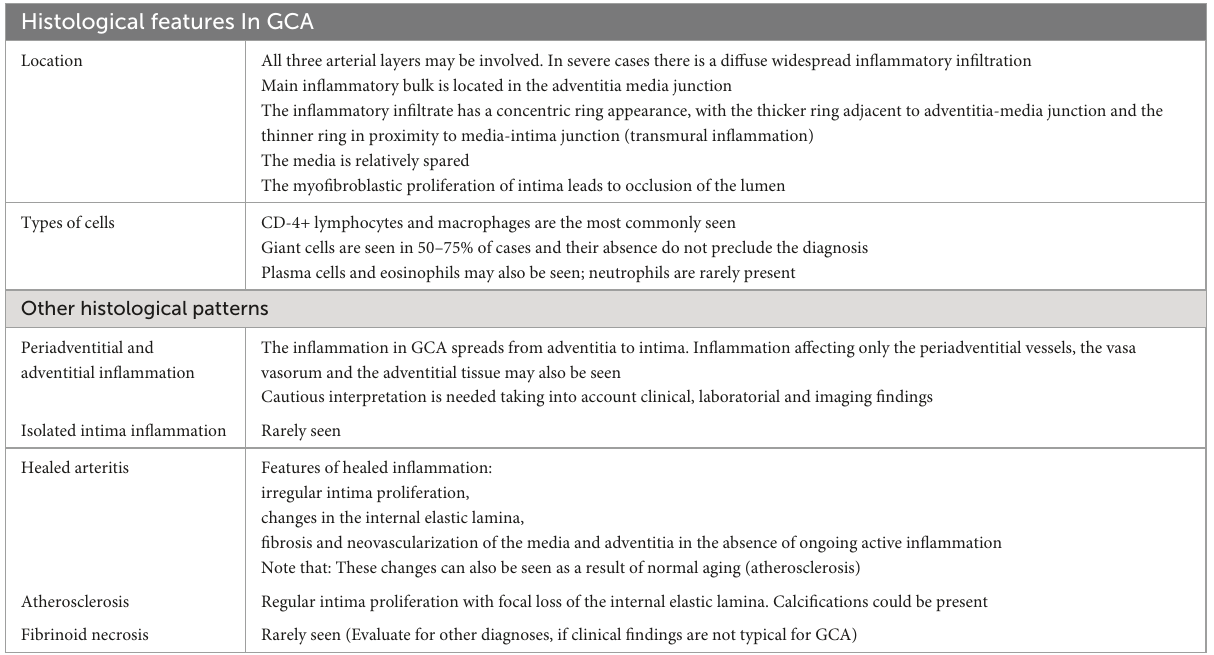
TABLE 4 Histological findings in patients with giant cell arteritis (GCA) (35). Histological features In GCA